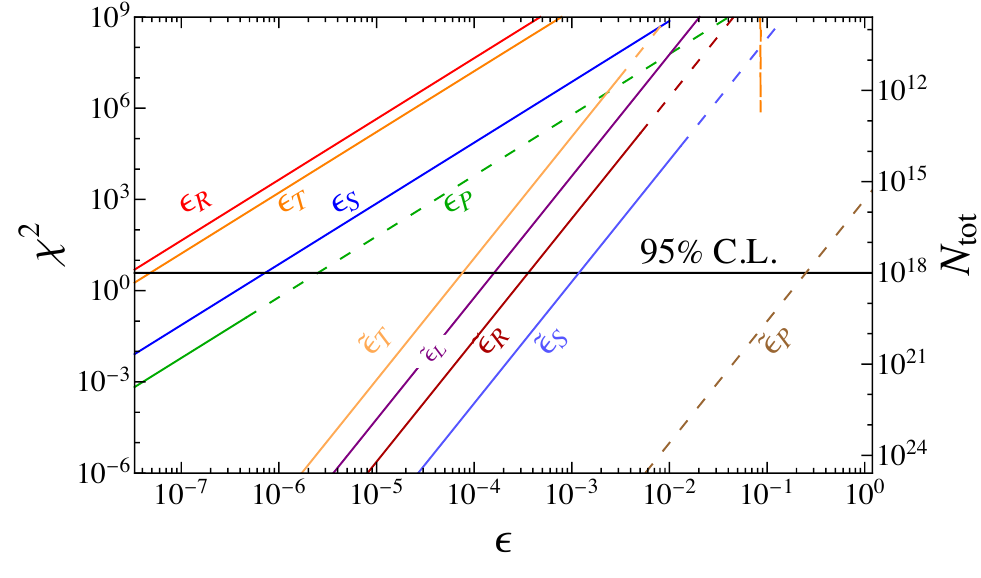
Figure 9 . As figure 8 but using the angular